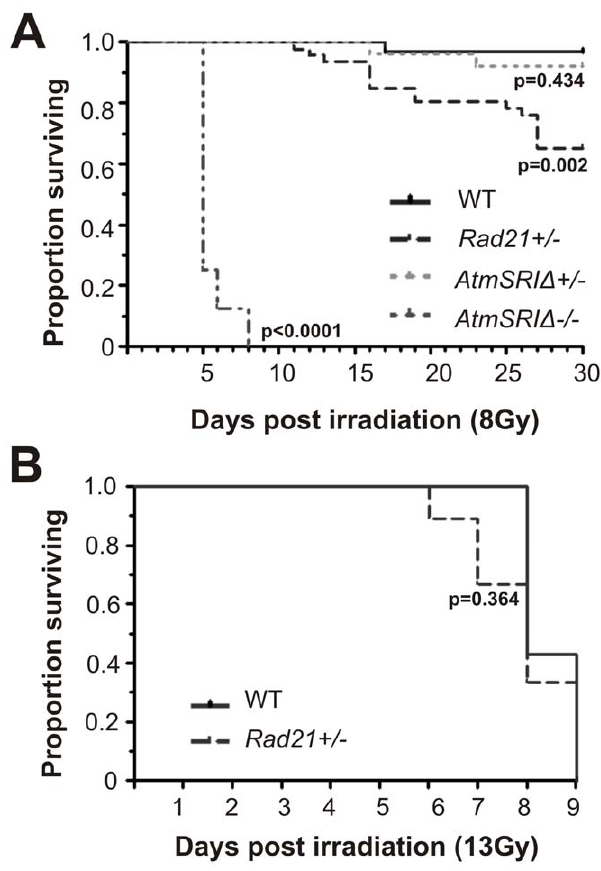
Figure 3. Kaplan-Meier plots of cumulative survival of Rad21 - cohesin and Atm mutant animals following WBI. A . Cumulative survival following 8Gy WBI is shown. Rad21 + / 2 : n=46; AtmSRI D + / 2 n=25; AtmSRI D 2 / 2 : n=8 and WT littermates: n=31. B . Cumulative survival following a higher dose of 13Gy WBI is shown. Rad21 + / 2 : n=9 and WT littermates: